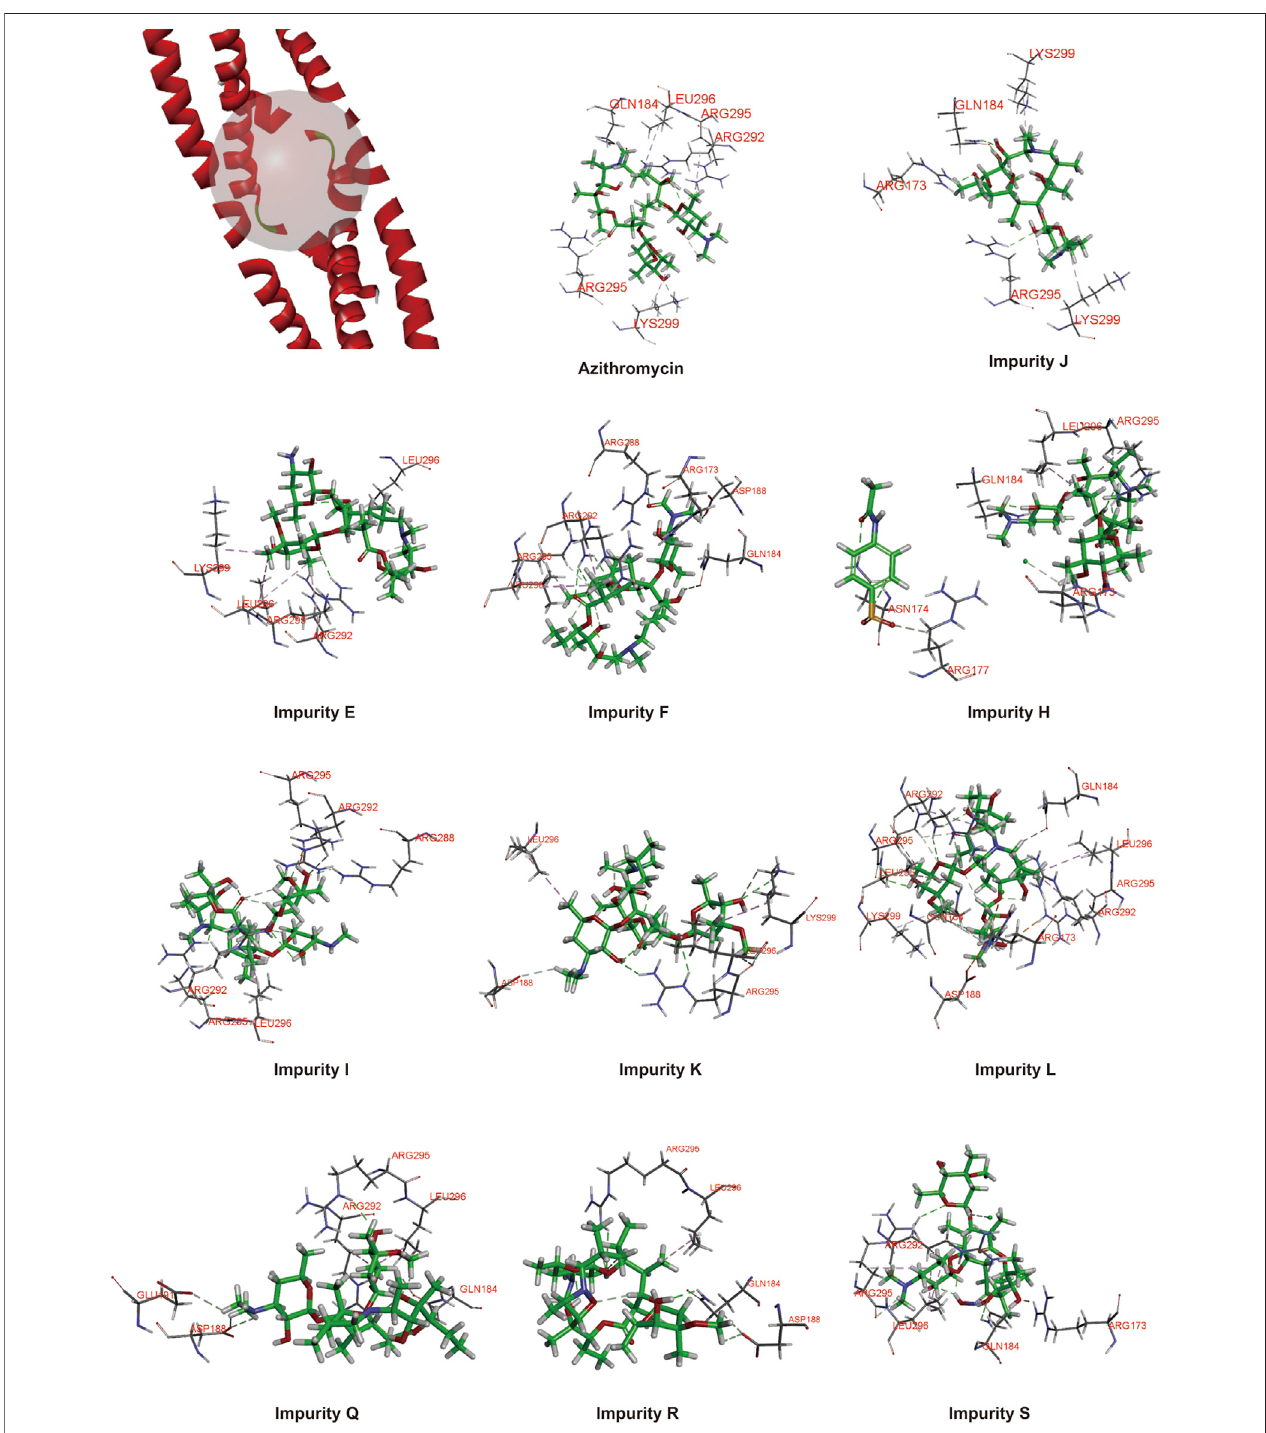
FIGURE 4 | Protein ligand docking of azithromycin and its impurities with FosB/JunD bZIP domain.